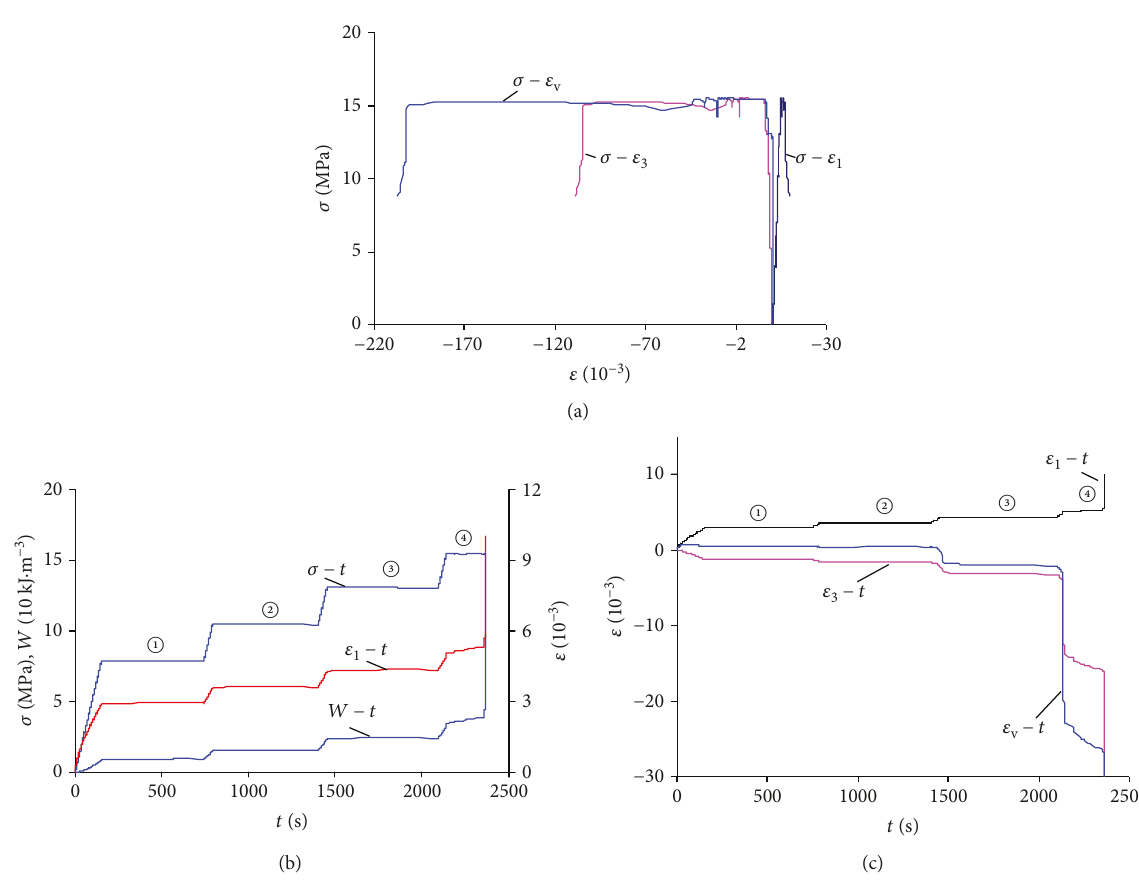
Figure 7: Complete stress (strain, energy) versus time curves for the step loading tests.